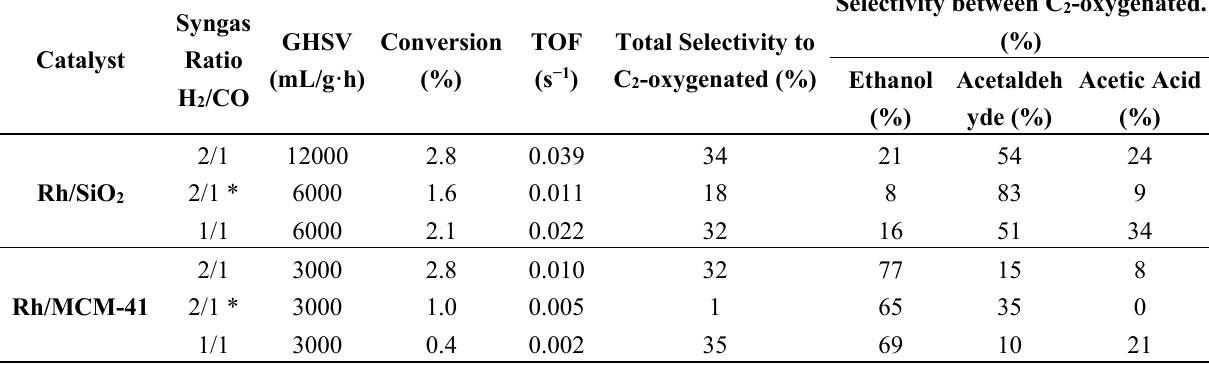
Table 1. Selectivity to C 2 -oxygenated compounds (ethanol, acetaldehyde and acetic acid) at different syngas ratios (H 2 /CO) and with/without addition of water. Temperature of 280 °C and pressure of 20